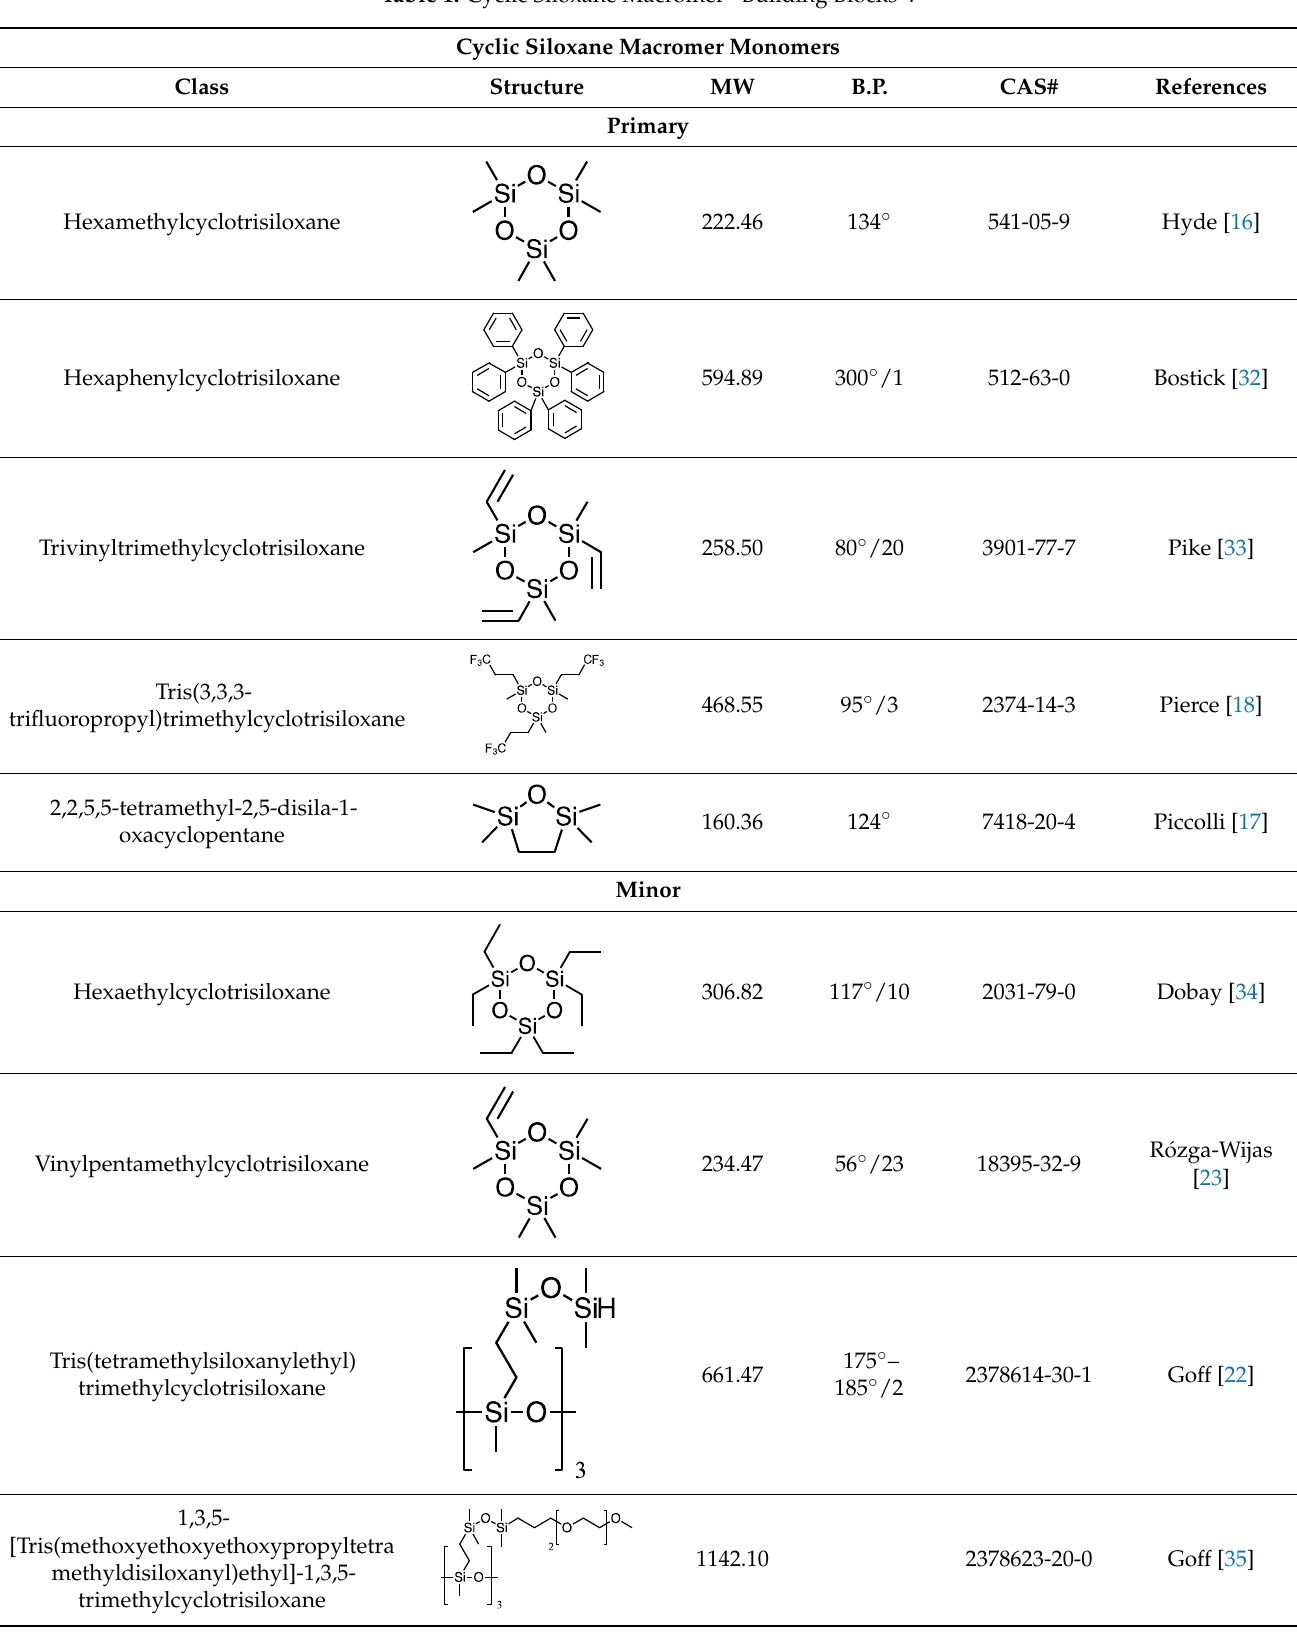
Table 1. Cyclic Siloxane Macromer “Building Blocks”.